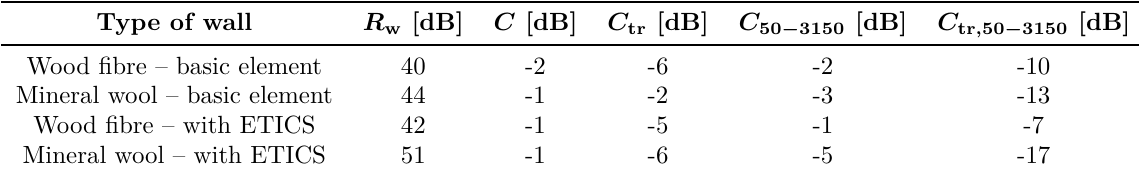
Table 4. Single number results for external walls.